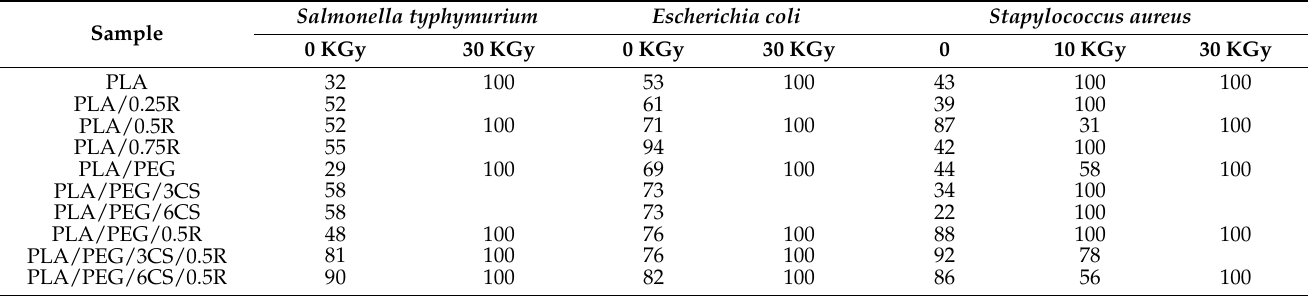
Table 6. Antibacterial activity as the percentage inhibition of the non-irradiated and irradiated PLA- based blend biocomposites against Salmonella typhymurium , Escherichia coli , and Stapylococcus aureus . Salmonella typhymurium Escherichia Sample